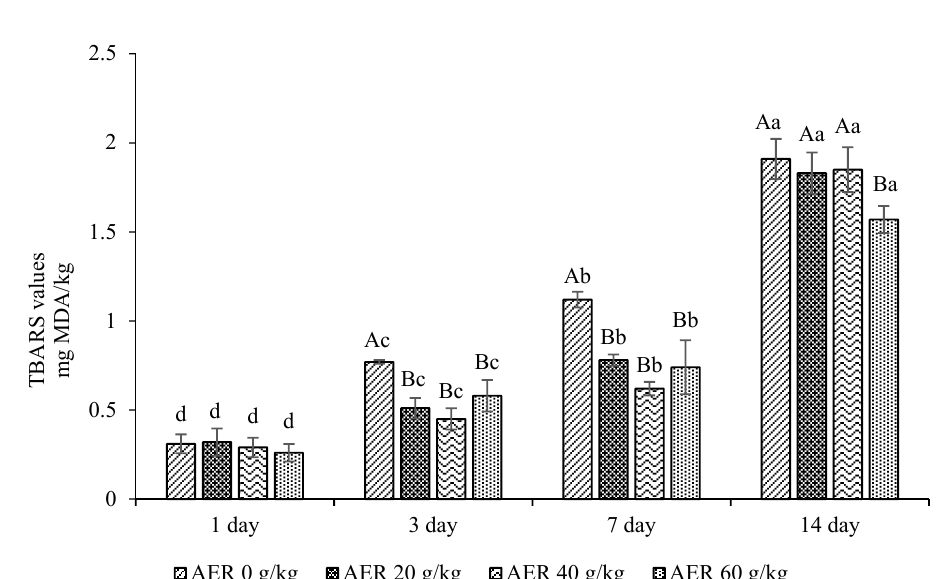
Figure 1. Thiobarbituric acid reactive substances (TBARS) values (mg malonaldehyde (MDA)/kg) of LD from male dairy cattle with AER in TMR diet at different storage time. A–B Least square means with different letters within the same day of storage time were significantly different ( p < 0.05); a–d Least square means with different letters within the same treatments were significantly different ( p < 0.05); AER: anthocyanin extracted residue; LD: Longissimus dorsi ; TMR: total mixed ration.